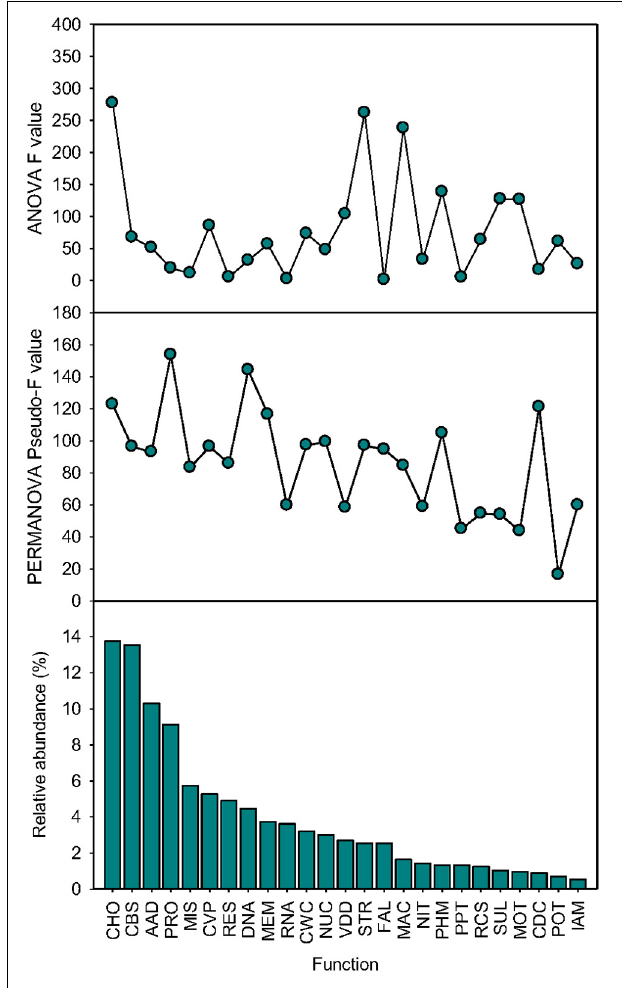
FIGURE 5 | Function-specific effects. The ANOVA statistical significance ( F value), the PERMANOVA statistical significance (pseudo- F value), and relative abundance of 25 dominant functional categories at level 1 (mean > 0.5%) influenced by sequential species loss. AAD, amino acids and derivatives; CBS, clustering-based subsystems; CDC, cell division and cell cycle; CHO, carbohydrates; CVP, cofactors, vitamins, prosthetic groups, pigments; CWC, cell wall and capsule; DNA, DNA metabolism; FAL, fatty acids, lipids, and isoprenoids; IAM, iron acquisition and metabolism; MAC, metabolism of aromatic compounds; MEM, membrane transport; MIS, miscellaneous; MOT, motility and chemotaxis; NIT, nitrogen metabolism; NUC, nucleosides and nucleotides; PHM, phosphorus metabolism; POT, potassium metabolism; PPT, phages, prophages, transposable elements, plasmids; PRO, protein metabolism; RCS, regulation and cell signaling; RES, respiration; RNA, RNA metabolism; STR, stress response; SUL, sulfur metabolism; and VDD, virulence, disease, and